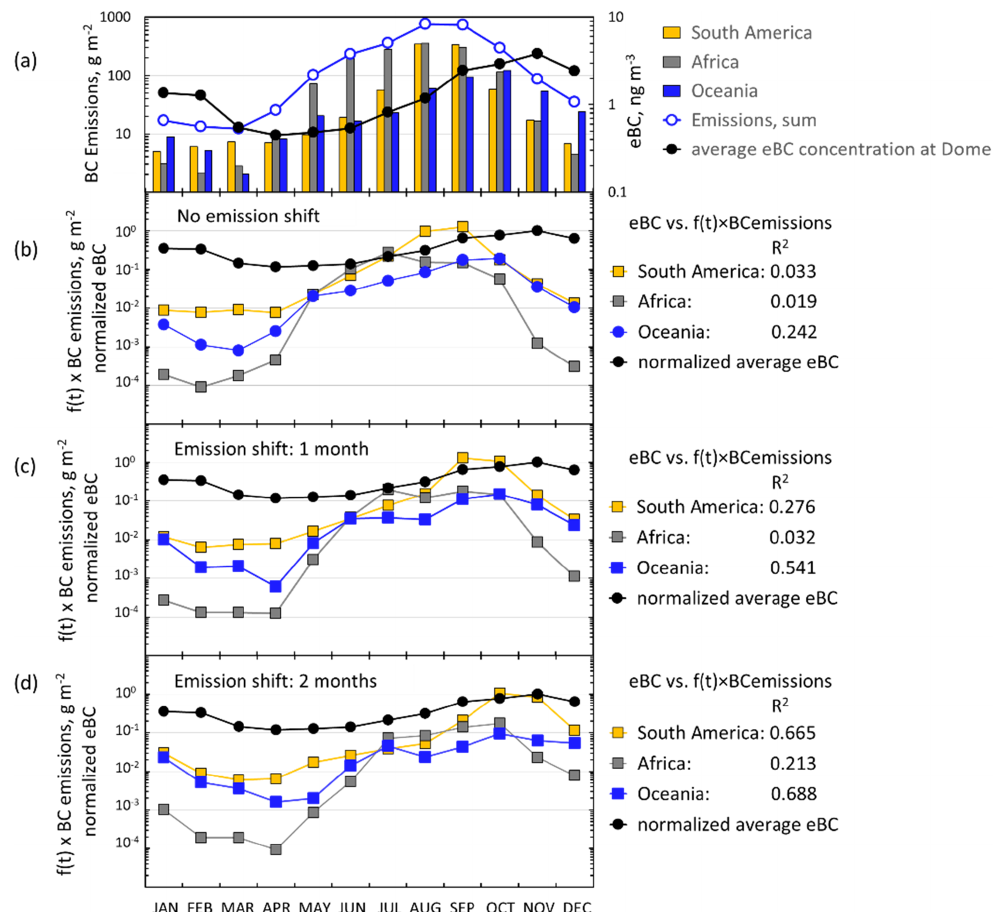
Figure 16. Seasonal cycles of fire-related BC emissions from the surrounding continents and eBC concentration at Dome C. (a) BC emissions and eBC concentrations, (b) RTW BC emissions, (c) f ( t ) × BC emissions 1 month earlier, and (d) f ( t ) × BC emissions 2 months earlier. The numbers show the squared correlation coefficient of linear regression between eBC concentrations and f ( t ) × BC emissions with the shown time